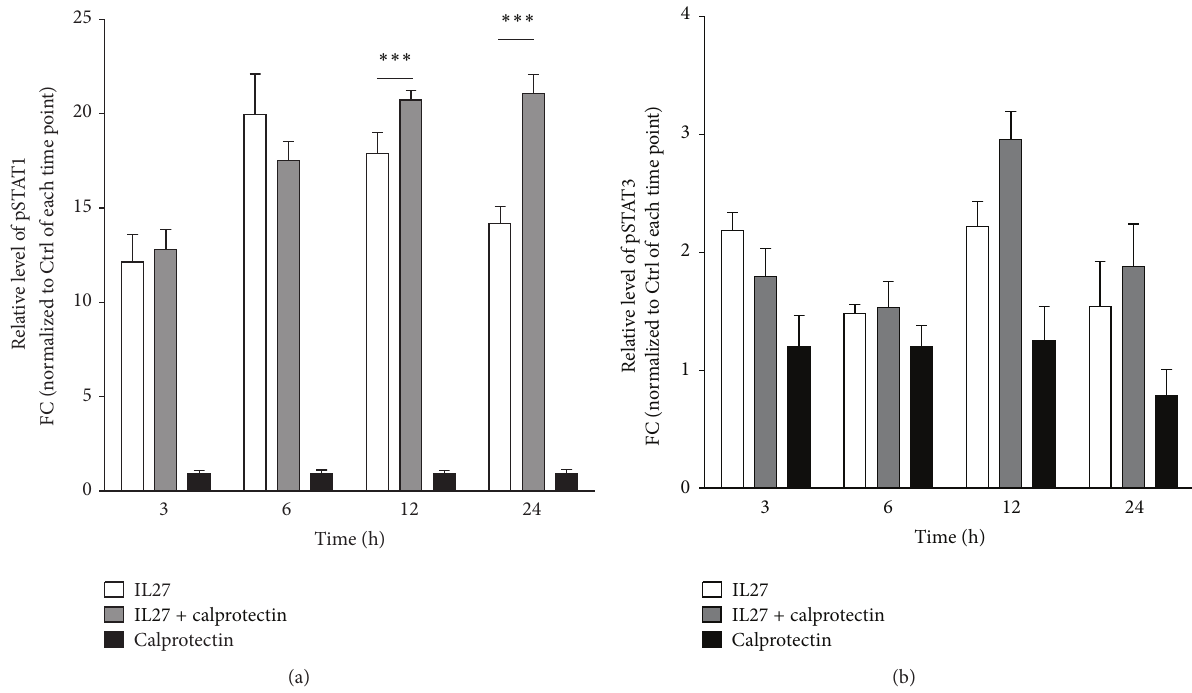
Figure 7: Effects of IL27, calprotectin, and IL27 + calprotectin cotreatment on STAT1/3 phosphorylation. Relative protein levels of Tyr701- phosphorylated pSTAT1 (a) and Tyr705-pSTAT3 (b) in IL27 (30 ng/mL) ± calprotectin (1 𝜇 g/mL)-stimulated HUVECs for 3, 6, 12, and 24 h performed by western blot. Values are represented as mean ± SEM. Normalization was performed against tubulin. Presented statistical significances are between IL27 and IL27 + calprotectin and the indicated 𝑝 values correspond to ∗∗∗ 𝑝 < 0.001